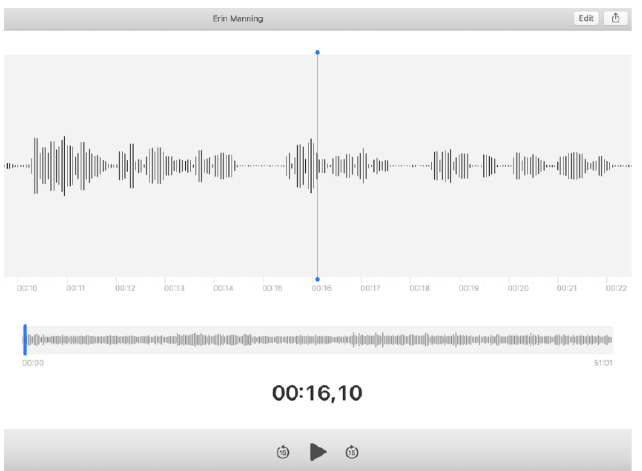
Figure 1 : Frame of the video clip of the voice memo on my laptop On watching the video clip of the voice memo on my phone screen I was astonished to discover that the different refreshing frequencies of the laptop and cell phone screens revealed animated patterns of difference that shimmered in the spaces between and beyond the lines of the sound waves (see Figure 2).